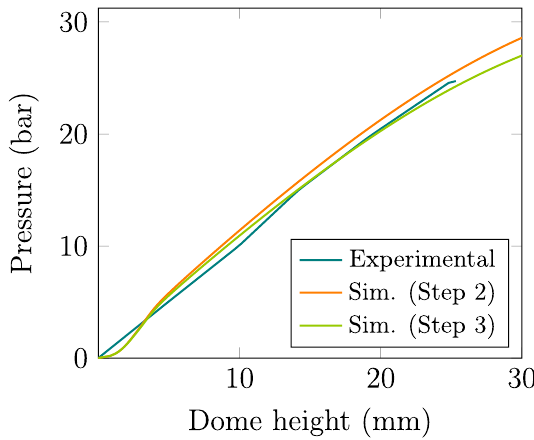
Figure 11. Average experimental, obtained after three tests, and computed pressure–dome height curve in the bulge